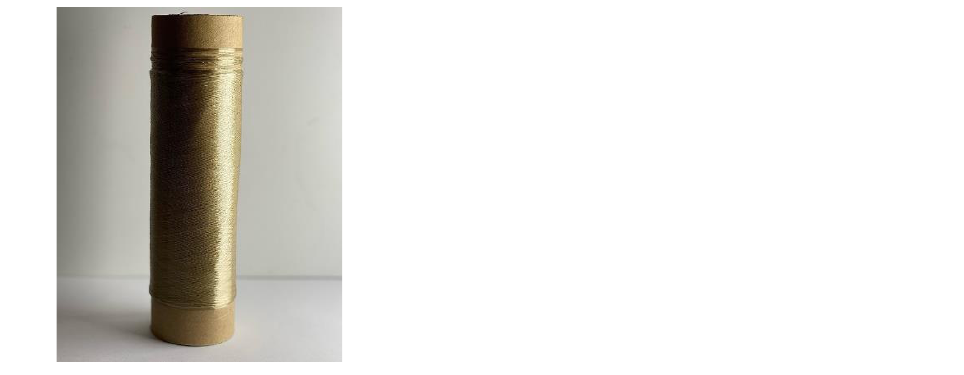
Figure 12. Micrographs of fibers spun from flax noils cellulose. As can be seen from the photographs, the surface of the monofilaments is smooth and even. The average fiber diameter is 16 – 18 microns. The cross section of the filaments is round with a dense texture. 3.5. Mechanical Properties The revealed structural and morphological features of flax noils fibers determine their mechanical properties. Table 2 shows the comparative mechanical properties of fi- bers formed from flax noils cellulose and wood pulp. Table 2. Mechanical properties of fibers spun from flax noils cellulose and wood pulp. C solution , % Diameter, μ m Strength, MPa Modulus, GPa Elongation, % 7 (flax noils)